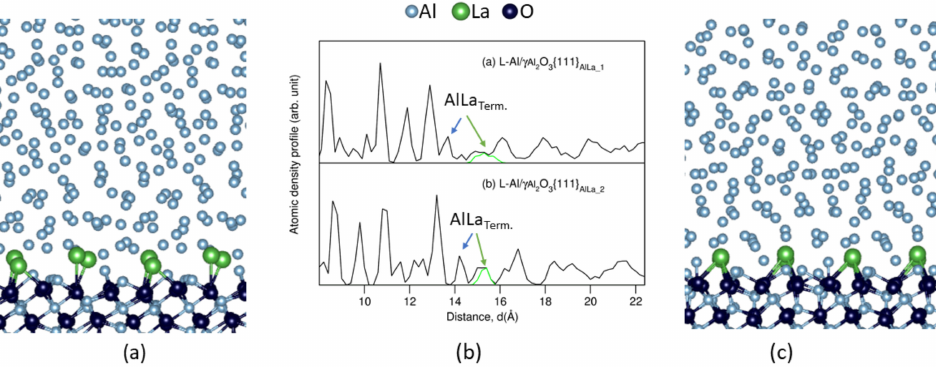
Figure 12. Segregation of La atoms at the Al( l )/ γ -Al 2 O 3 {1 1 1} induces atomic roughness at the oxide substrates. Snapshots of Al( l )/ γ -Al 2 O 3 {1 1 1} (AlLa)_1 ( a ) and Al( l )/ γ -Al 2 O 3 {1 1 1} (AlLa)_2 ( c ) systems and their atomic density profiles ( b ) equilibrated at 1000 K